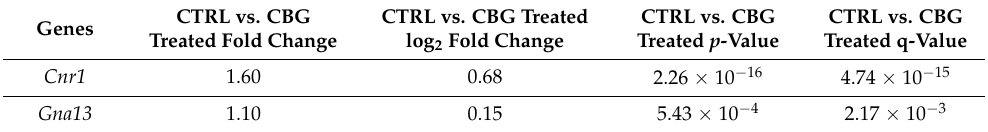
Table 1. Differentially expressed genes involved in CB1 signaling. Genes